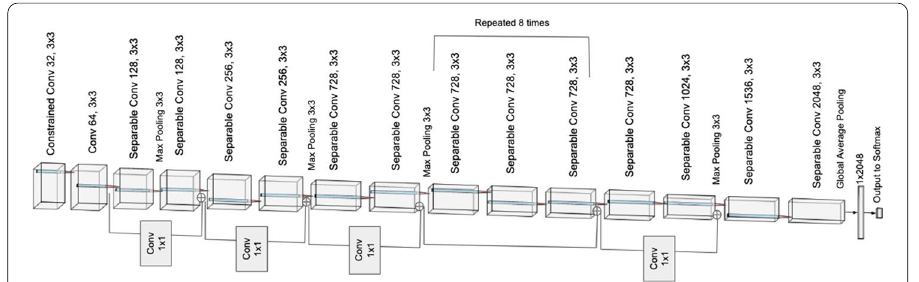
Fig. 1 Proposed network architecture. The first layer is a constrained convolutional layer to extract SRM features, followed by an deep architecture with separable convolutional layers to improve generalization. The last layer is either a 4 1 vector (for four classes) or a 6 1 vector (for all six × ×